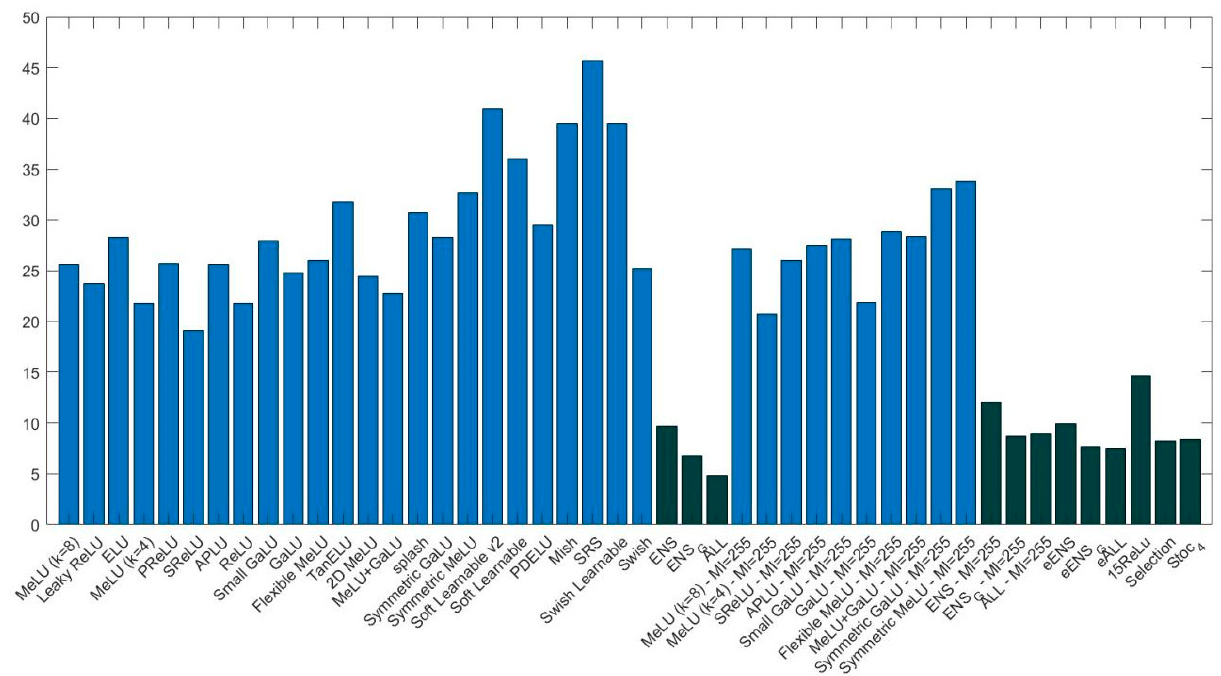
Figure 6. Average rank (lower is better) obtained by different AFs and ensembles coupled with VGG16 (light blue represents stand-alone methods and dark blue, ensembles). To further substantiate the power of different AFs in ensembles with small to midsize data sets, in Table 6, we show a further batch of tests comparing 15ReLU and the ensem- bles built by varying the activation functions to the performance of five different CNN topologies, each trained with a batch size (BS) of 30 and a learning rate (LR) of 0.001 for 20 epochs (the last fully connected layer has an LR 20 times larger than the rest of the layers (i.e., 0.02)) using Matlab2021b. Note that these parameters are slightly different from those of the previous tests. We did not run tests using VGG16 due to computational issues. Table 6. Ensemble performance (accuracy) on a set of different topologies (due to the high computa- tional time for CO we have run only 4 Sto_4